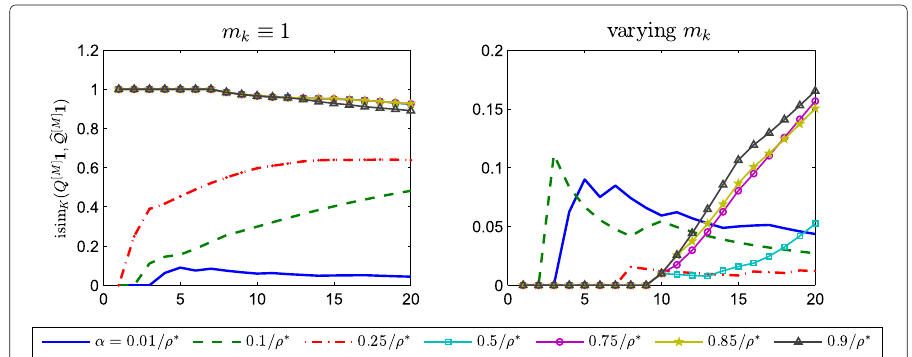
(cid:4) (cid:5) Q [ M ] 1 , (cid:12) Q [ M ] 1 versus K , for different